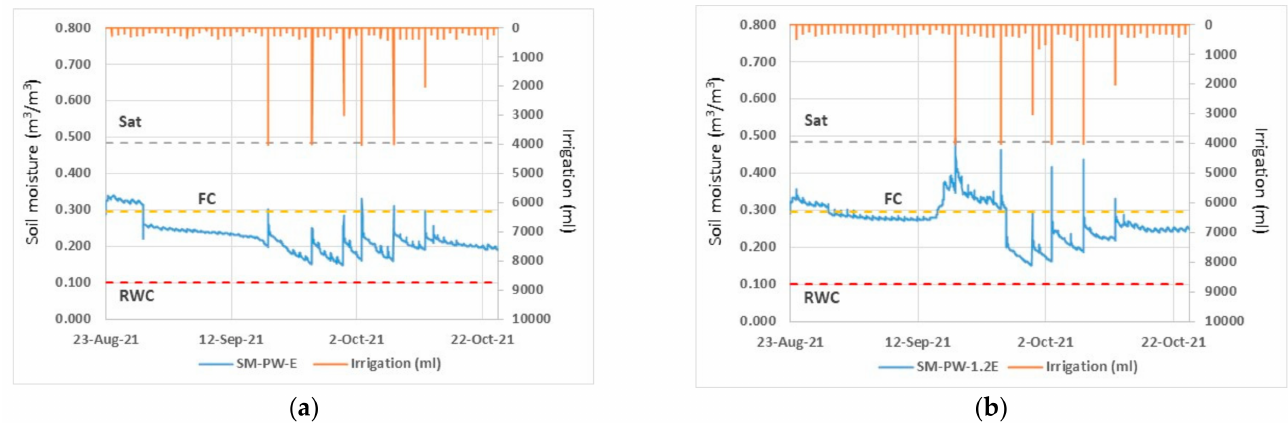
Figure 9. The fluctuation in soil moisture and irrigation: ( a ) PW-E treatment, ( b ) PW-1.2E treatment. Note: Sat: saturated water content, FC: field capacity water content, RWC: residual water